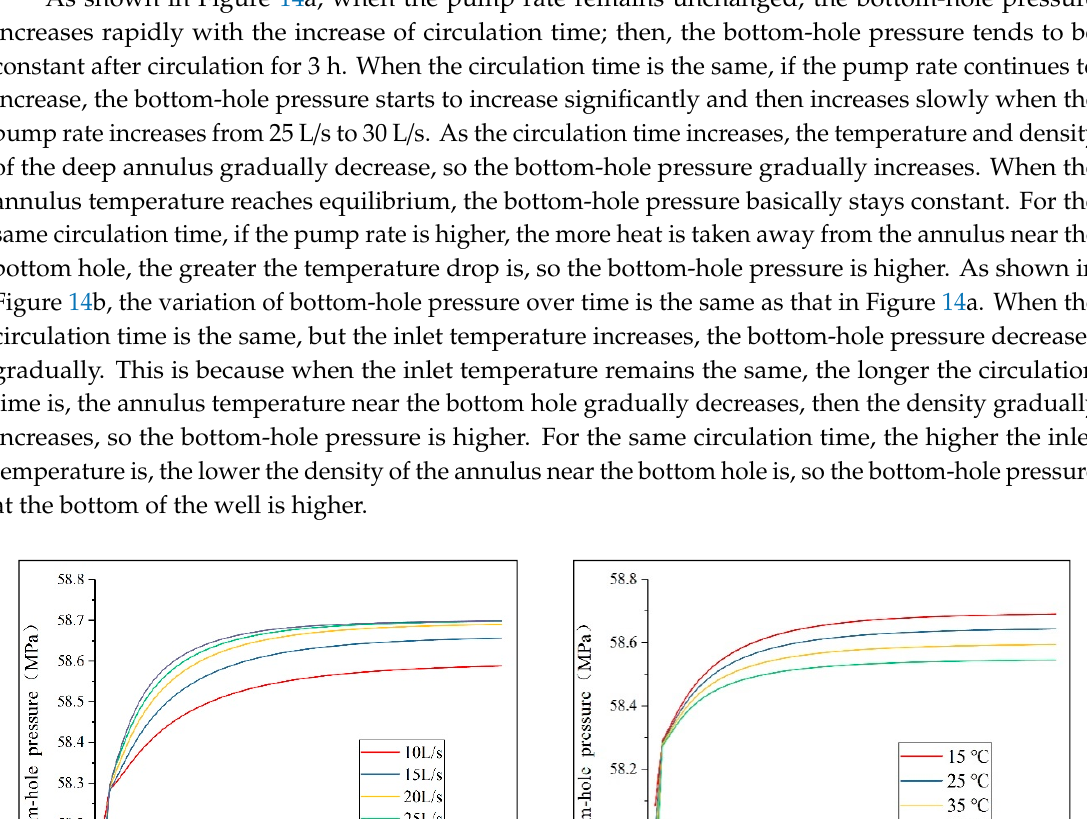
Figure 13. Variation of density and viscosity at different overflow and leakage rates. ( a ) Variation of density when the multi-pressure system is located in the middle formation; ( b ) Variation of viscosity when the multi-pressure system is located in the middle formation; ( c ) Variation of density when the multi-pressure system is located at bottom hole; ( d ) Variation of viscosity when the multi-pressure system is located at bottom hole.